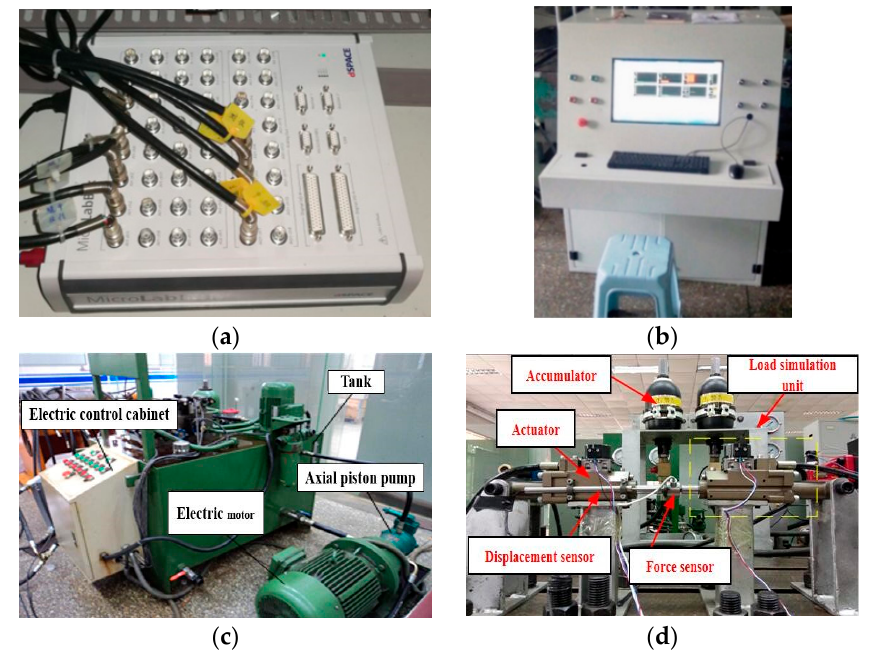
Figure 9. Test Platform for Load Simulation Performance of Braking Pressure Servo Valve-Controlled Cylinder System. ( a ) dSPACE controller. ( b ) Electric control cabinet. ( c ) Experimental station. ( d ) Experimental system organization.